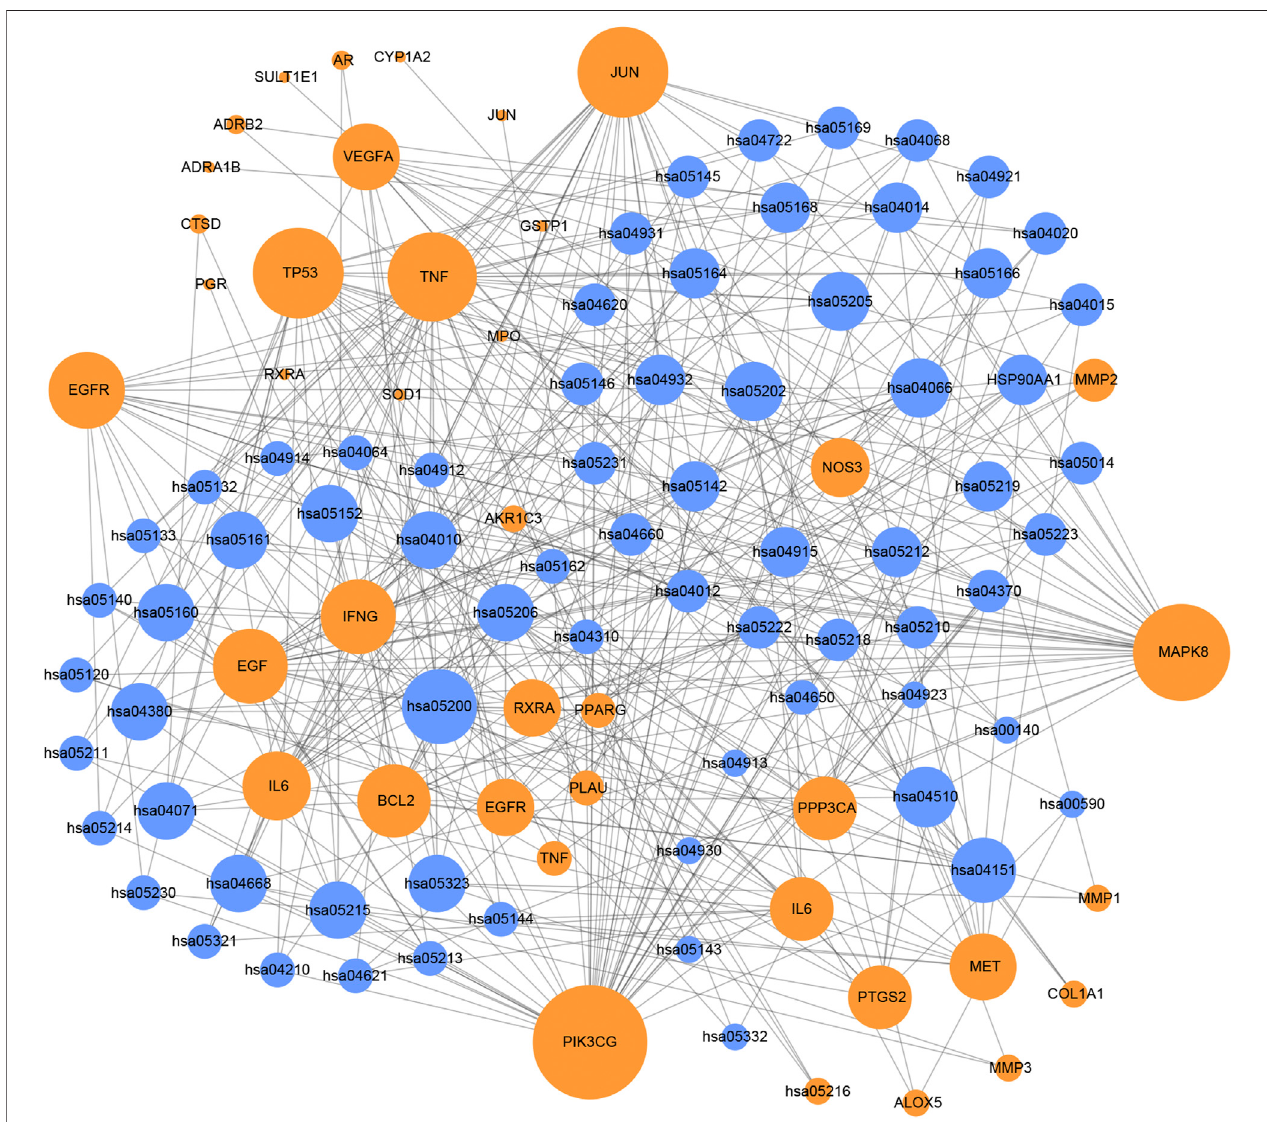
FIGURE 6 | Target – pathway network. Blue nodes represent pathways, and orange nodes represent targets. The node size is proportional to its degree.